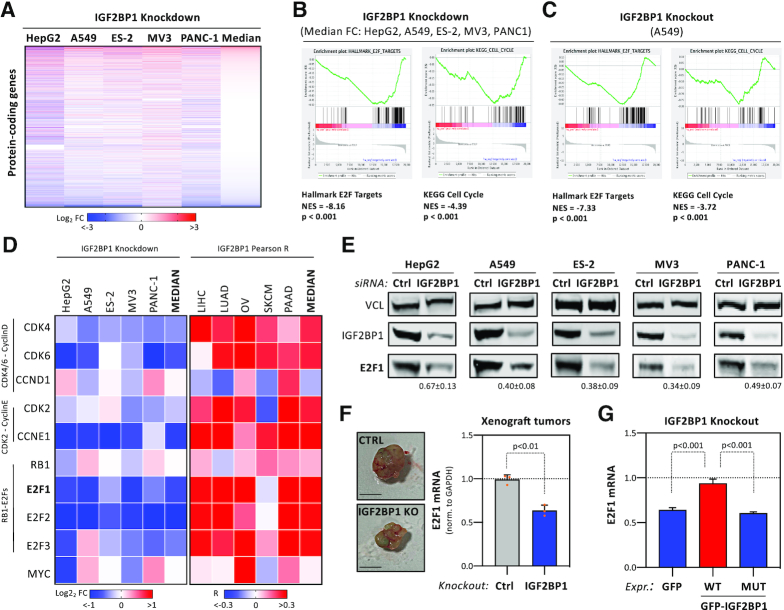
IGF2BP1 controls G1/S cell cycle transition of cancer cells. (A) Heatmap indicating the fold change (FC) of mRNAs upon IGF2BP1-depletion in indicated cancer cell lines 72 h post-transfection of siRNAs. The abundance of mRNAs was monitored by RNA sequencing. Genes were ranked according to their median FC determined in five cancer cell lines. (B, C) Gene set enrichment analysis (GSEA) of median FC of protein-coding genes upon IGF2BP1 depletion in five cancer cell lines (B) or upon IGF2BP1 knockout in A549 cells (C). Results for the KEGG pathway ‘Cell Cycle’ (left) and the Hallmark pathway ‘E2F Targets’ (right) are shown. NES, normalized enrichment score. (D) Heatmap depicting the fold change of indicated mRNAs upon IGF2BP1 depletion in cancer cells (left) and their correlation (coefficient) with IGF2BP1 mRNA expression in indicated cancers (right). Median fold change or correlation coefficients are indicated in most right columns. (E) Representative Western blot analyses of E2F1 upon IGF2BP1 depletion in indicated cancer cell lines. Vinculin (VCL) served as a loading and normalization control. Average fold change and standard deviation of E2F1 protein levels, determined in three independent analyses are indicated in bottom panel. (F) RT-q-PCR analysis of E2F1 mRNA levels in excised xenograft tumors (Figure 2G). Representative images of tumors are shown in the left panel. E2F1 expression was determined in three control and IGF2BP1-KO tumors by normalization to GAPDH. (G) RT-q-PCR analysis of E2F1 mRNA levels in IGF2BP1-KO A549 cells expressing GFP, GFP-IGF2BP1 (WT) or an RNA-binding deficient GFP-IGF2BP1 (MUT) normalized to parental A549 cells. RPLP0 served as normalization control. Statistical significance was determined by Student's t-test.